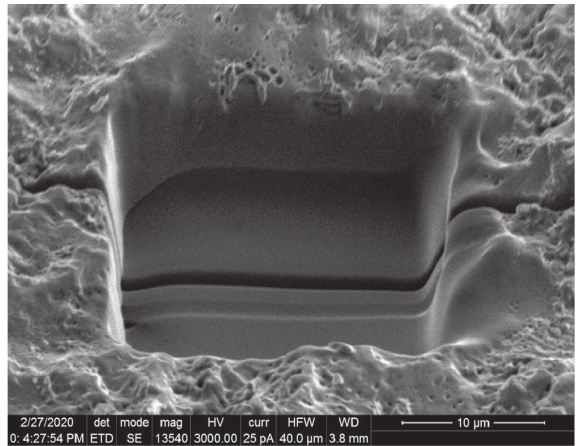
Figure 12: LR White milled with N + at 30kV.